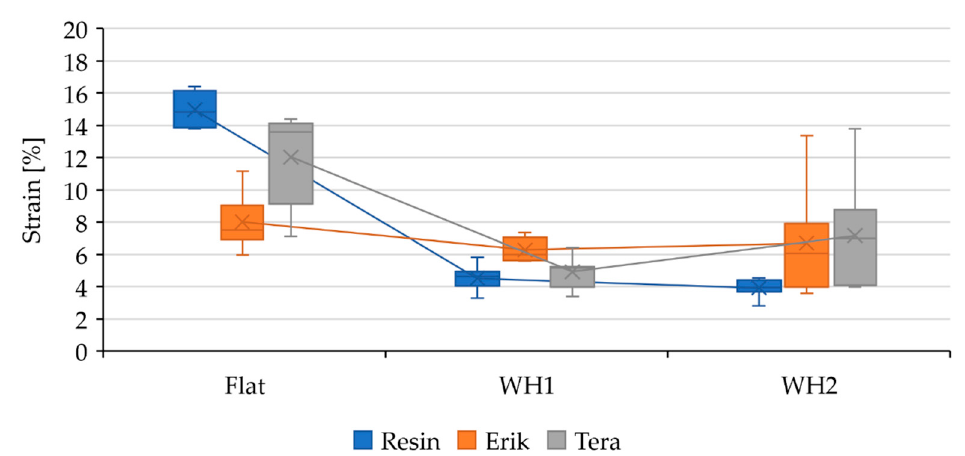
Table 6. Results of cyclic tensile tests of adhesive bonds in the load intervals 5–50% and 5–70%. Adhesive Bond